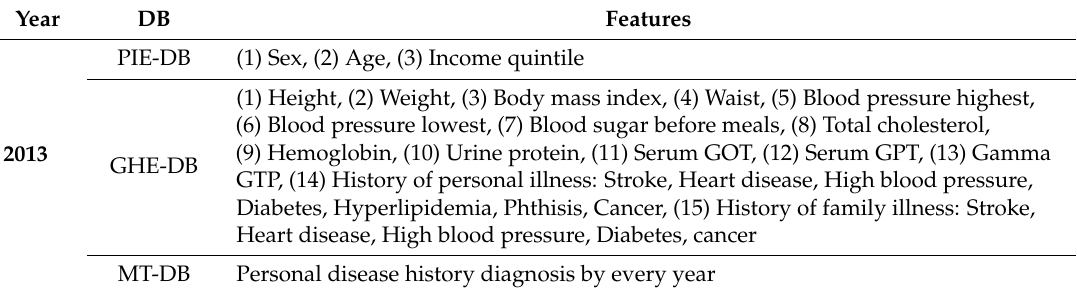
Table 6. Features of baseline experiment.